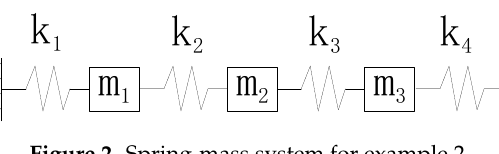
Figure 2. Spring-mass system for example 2.